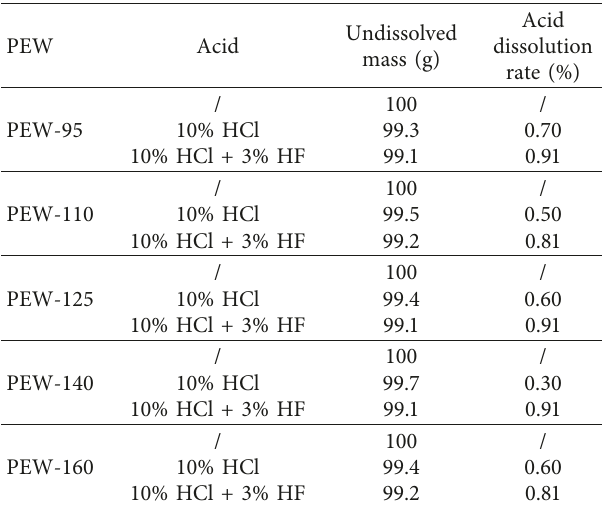
Table 4: The results of acid solubility of polyethylene wax.